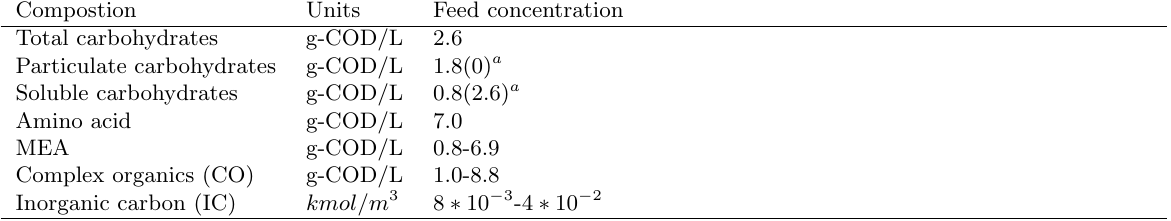
Table 2: Characterizations of the feed